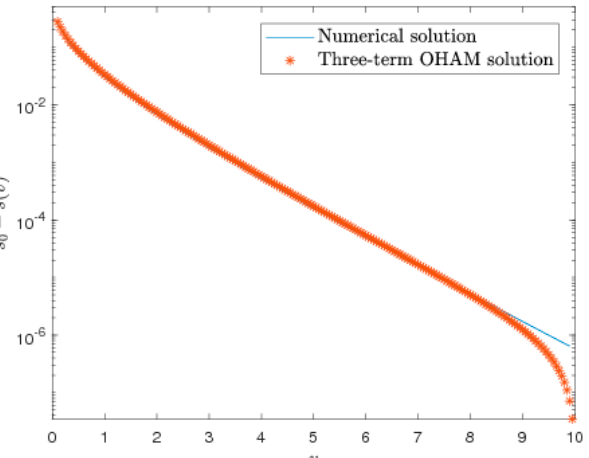
Figure 10. Comparison between the Theis solution and the three terms of OHAM-based solution for the selected case. Table 4. Comparison between three terms of the OHAM-based approximation and Theis solution for the selected case.